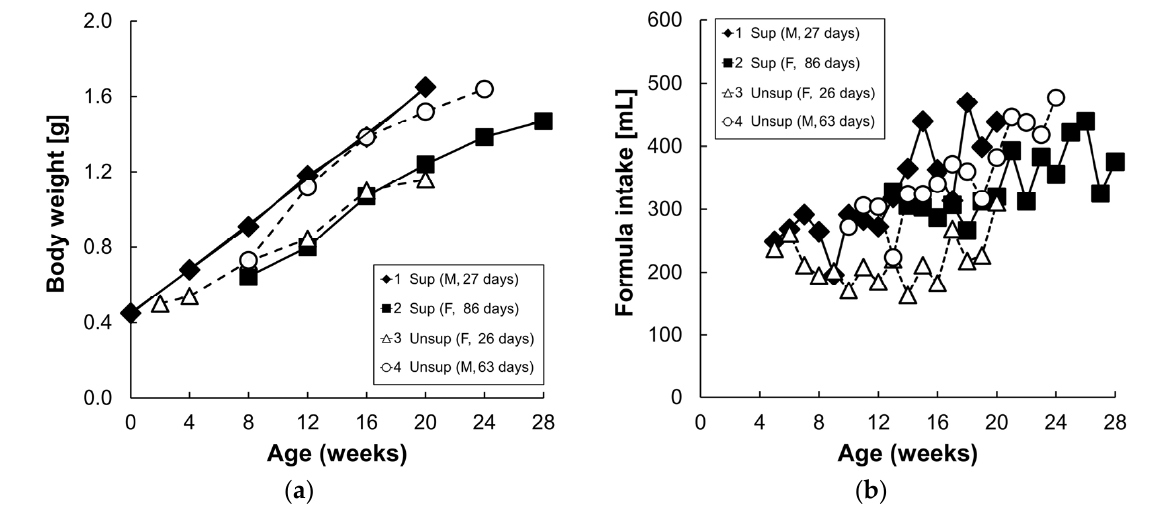
Figure 2. Body weight ( a ) of each infant monkey and daily formula intake consumed by infant monkeys ( b ) for 16 weeks. Each symbol represents one animal; solid symbol and solid line denote supplemented formula (Sup) while the open symbol and dotted line denote unsupplemented formula (Unsup).